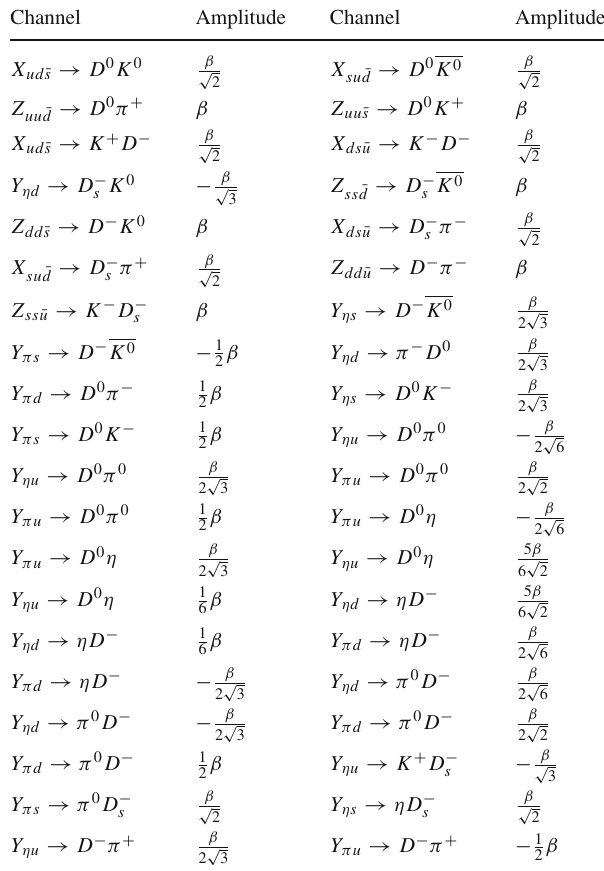
Table 3 Decay amplitudes of X c → D i P for ¯ 6 representation tetraquarks containing X 0 ( 2900 ) . The results can be easily applied to X